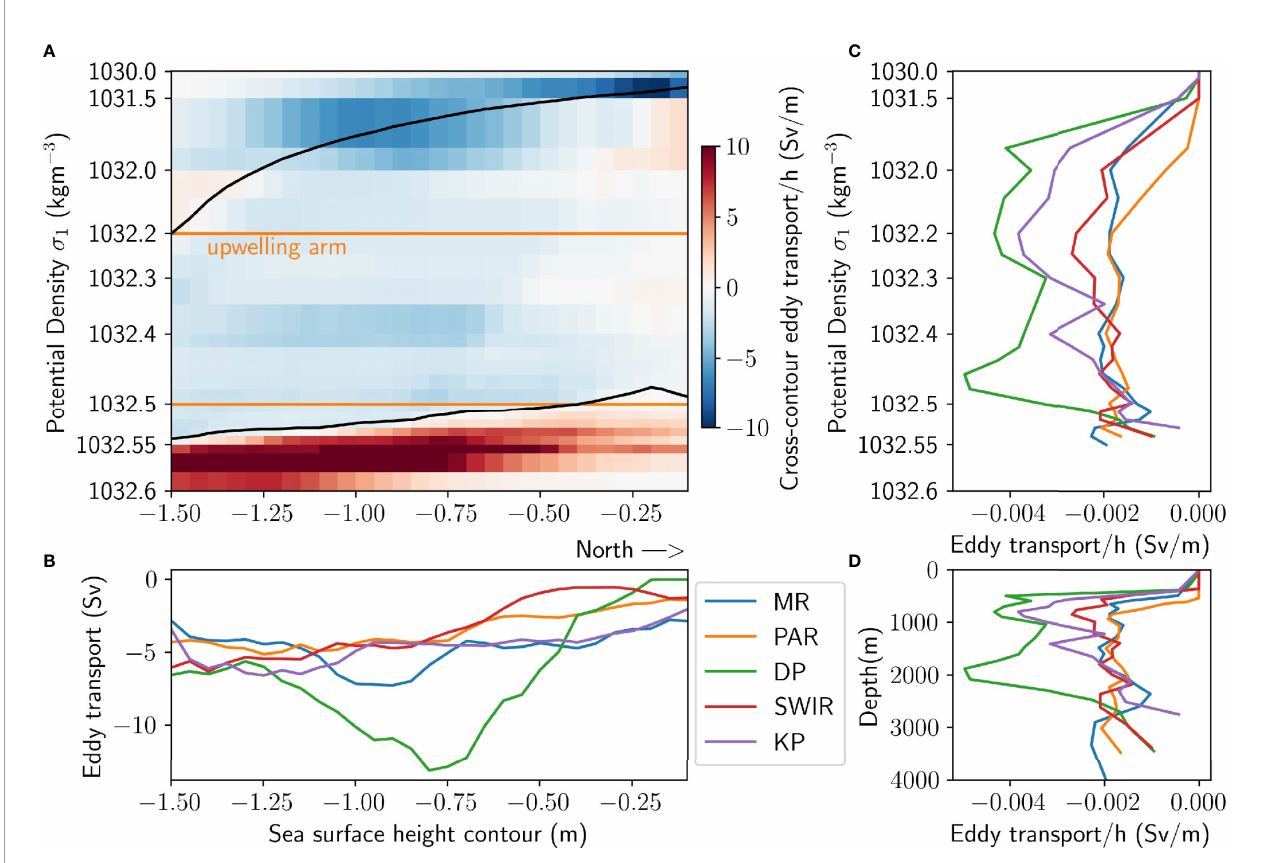
FIGURE 8 | Cross-contour eddy transport in each isopycnal layer integrated along circumpolar SSH contours, T ( r , C) (A) . The upper black line is the average surface density of each SSH contour, and the lower black line is the density bounding southward eddy transport, averaged along circumpolar contours. For each hotspot, the transport between the (hotspot-equivalent) two black lines is averaged over all contours (B) and integrated over upwelling densities (C) giving eddy transport distributions in density and SSH contour space respectively. The density distribution from B is mapped into depth space in (D) . The hotspots are Macquarie Ridge (MR), Paci fi c-Antarctic Ridge (PAR), Drake Passage (DP), Southwest Indian Ridge (SWIR), and Kerguelen Plateau